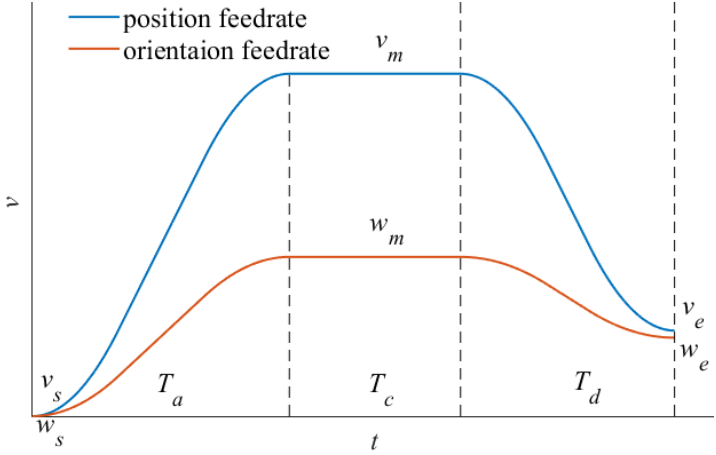
Figure 6. Illustration of feedrate deformation